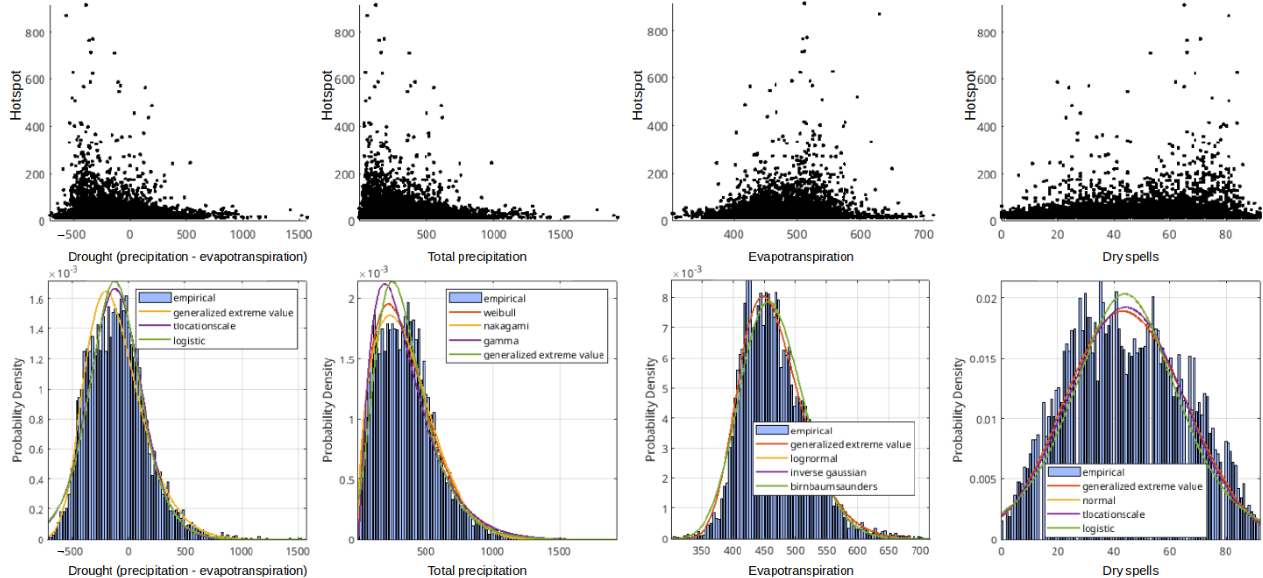
Figure 7. Scatter plot between hotspot and climate indicators (drought, total precipitation, evapotranspirartion, and dry spells) as well as climate indicators distribution.